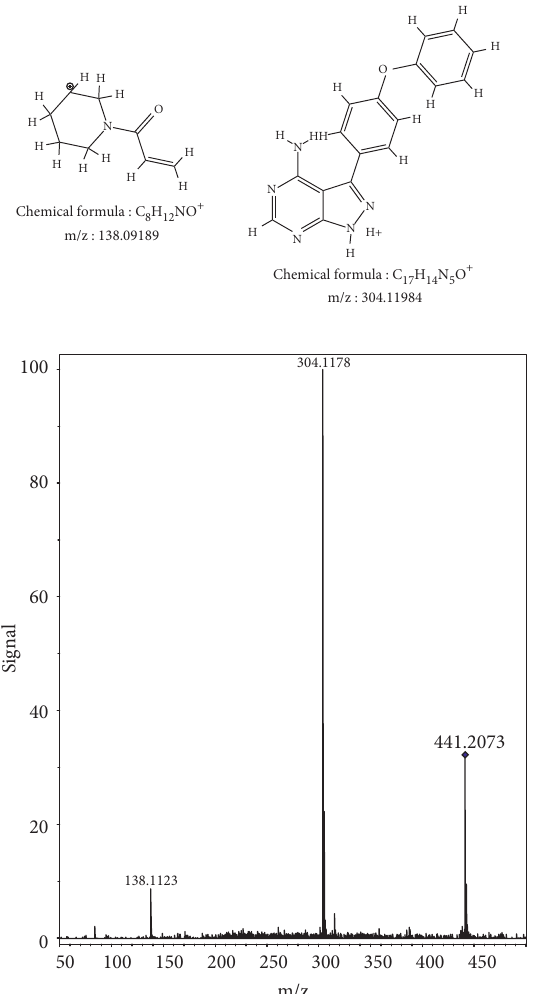
Figure 5: Ibrutinib’s tandem mass spectrum with a direct fusion of methanol solution using a high-resolution electrospray ionization mass spectrometer at a collision energy of 25 Joule. Two fragments were found at m/z � 304.1178 and 138.1123, corresponding to the pyrazole pyridine bond breakage.